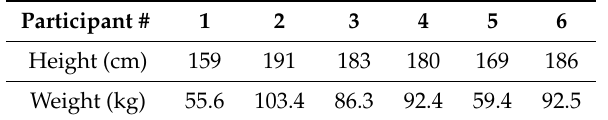
Table 1. Height and weight of the six volunteers who participated in our